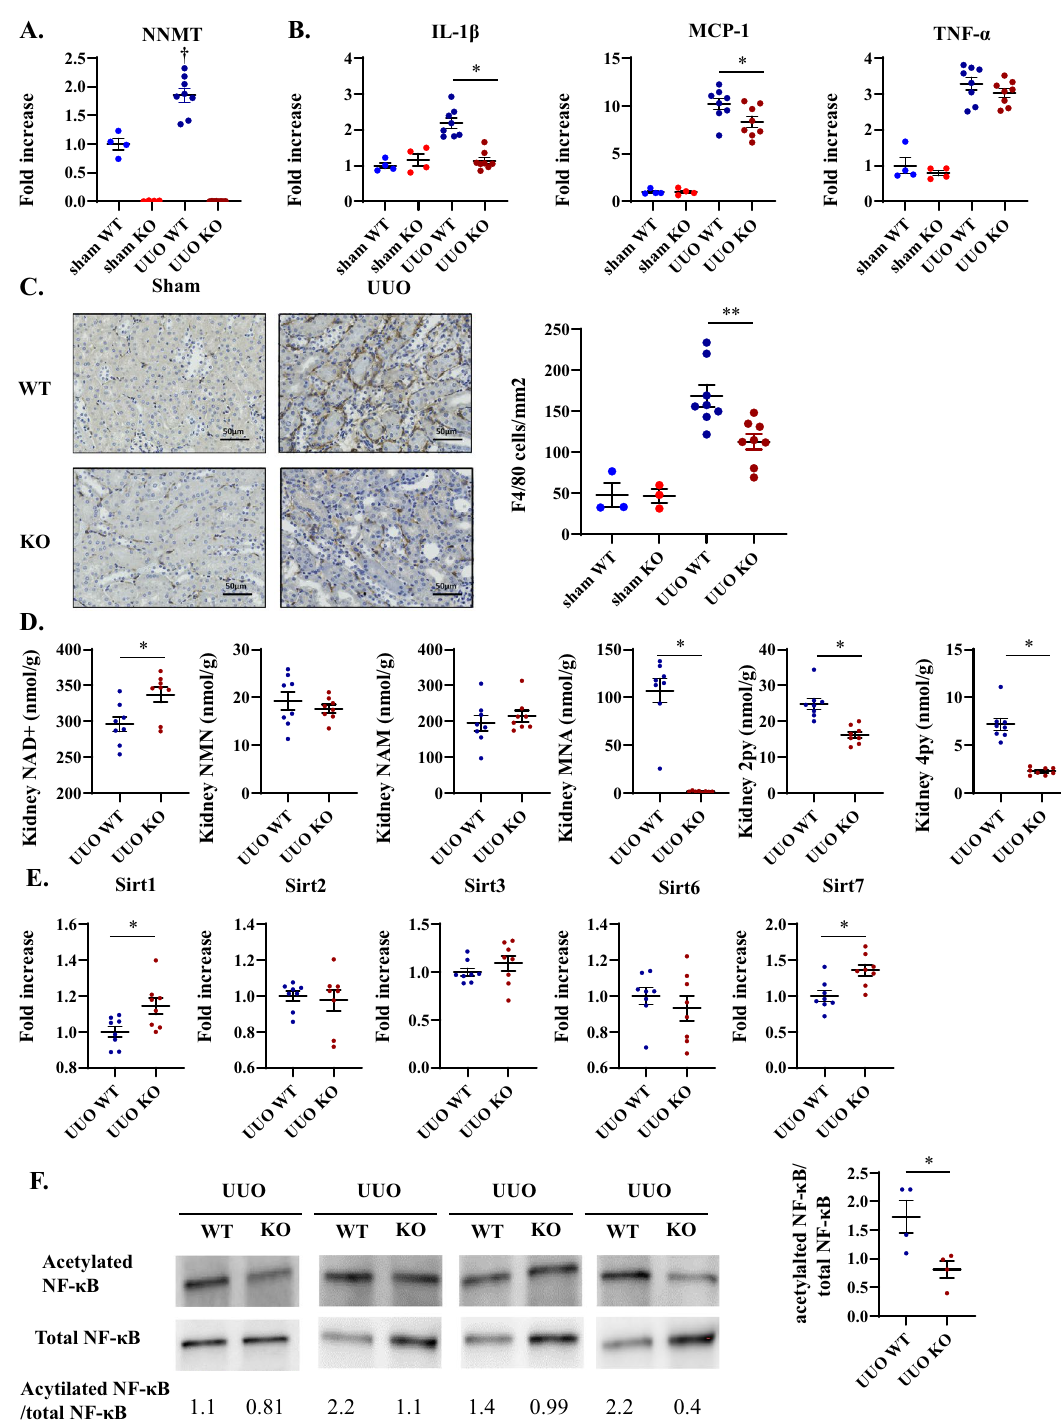
Figure 5. NNMT deficiency ameliorates renal inflammation in the UUO model. Renal NNMT mRNA expression ( A ), inflammation-related genes ( B ), renal NAD + metabolites ( D ), and mRNA expression of sirtuins ( E ) were measured in the kidneys of NNMT-KO mice and WT littermates two days after UUO induction. The data represent means ± SEM ( n = 4–8 per group). ( C ) IHC staining and quantitative analysis for F4/80. The data represent means ± SEM ( n = 3–8 per group). ( F ) The acetylation status of NF-κB in the kidney after UUO induction ( n = 4 per group). Full-length blots/gels are presented in Supplementary Fig. 7. UUO, unilateral ureter obstruction; NNMT, nicotinamide N-methyltransferase; Il-1β, interleukin 1-beta; MCP-1, monocyte chemotactic protein-1; TNF-α, tumor necrosis factor-alpha; NAM, nicotinamide; NMN, nicotinamide mononucleotide; NAD + , nicotinamide adenine dinucleotide; MNA, 1-methylnicotinamide; N-Me-2PY, N-methyl-2-pyridone- 5-carboxamide; N-Me-4PY, N-methyl-4-pyridone-3-carboxamide; NF-κB, nuclear factor-kappa B. * P < 0.05, ** P < 0.01 versus WT mice; † P < 0.05, †† P < 0.01 versus the same genotype control mice (sham-operated